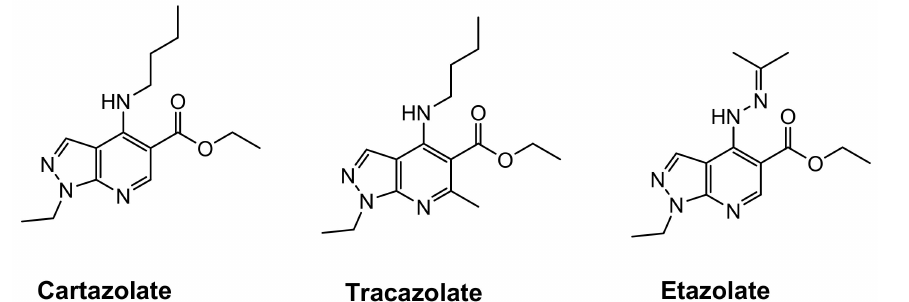
Figure 1. Examples of marketed pyrazolopyridine drugs.